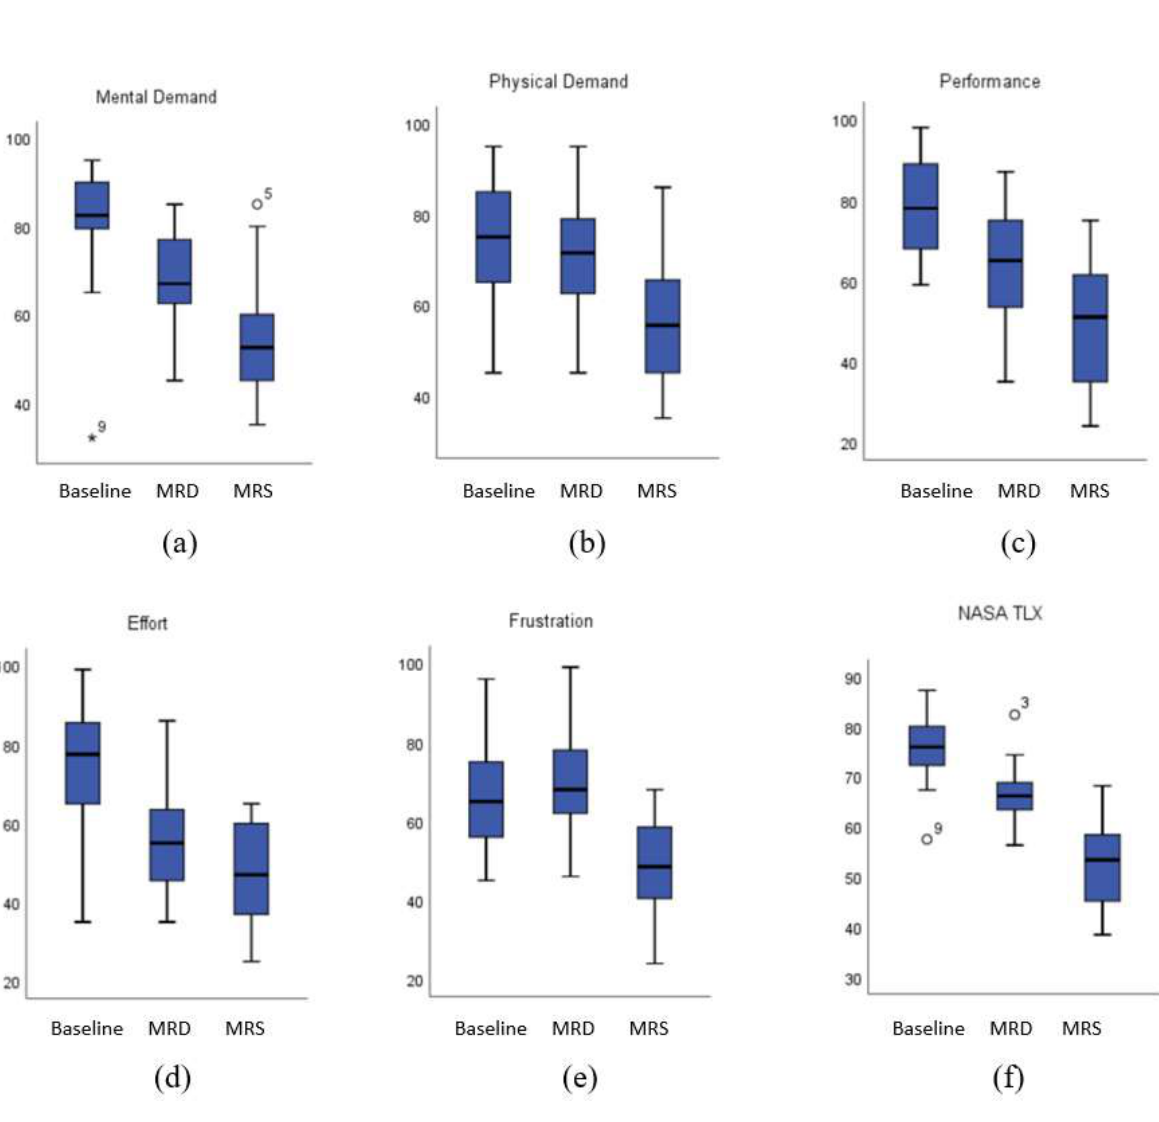
Figure 6. Boxplots of workload measures for each HRI scheme across two tasks. MRD and MRS denote MR SpaceMouse and MR subspace, respectively.